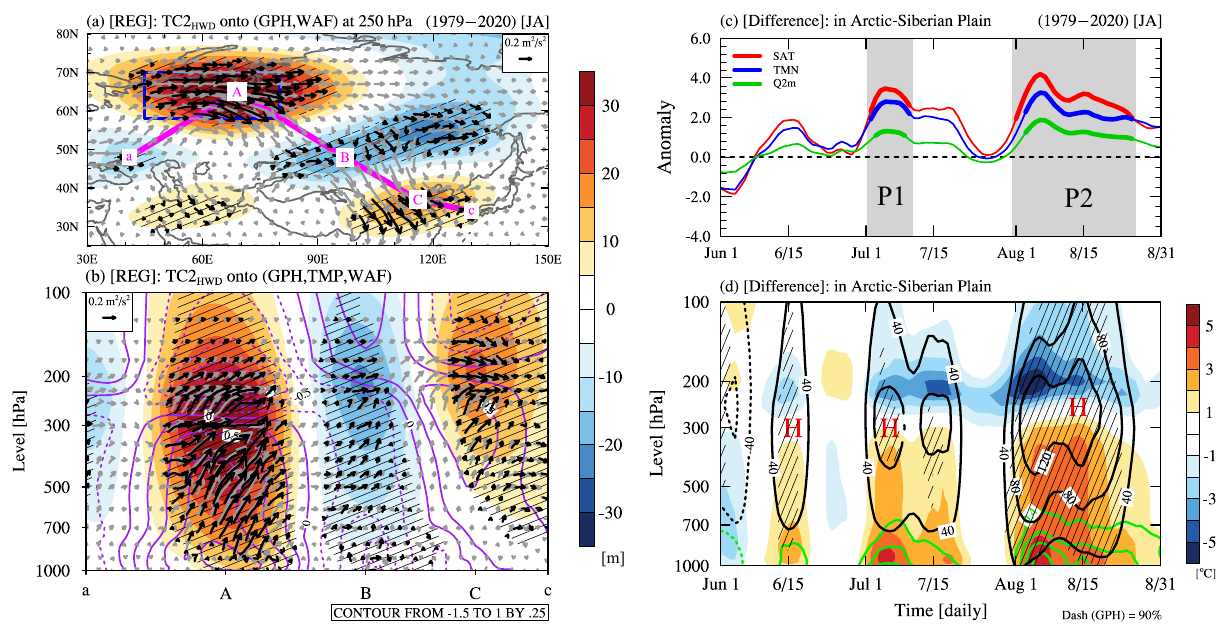
Figure 3. Regression and composite pattern associated with the Arctic-Siberian Plain (ASP). ( a and b ) Horizontal and vertical regression patterns between the 2nd SVD mode time coefficients (TC2) for heatwave days (HWD) (TC2-HWD) and geopotential height (GPH; shading; units: m), wave activity flux (WAF; vector; unit: m 2 /s 2 ), and air temperature (TMP; purple line; unit: °C). The blue rectangle in ( a ) indicates the ASP region (58°N–70°N, 45°E–80°E). The solid pink line indicates a Rossby wave pathway. The black vectors indicate statistically significant values at a 90% confidence level. ( c and d ) Composite difference between heatwaves associated with ASP (HW-ASP) and non-heatwaves associated with ASP (NHW-ASP) for ( c ) 7-day running mean surface air temperature (SAT; red line; unit: °C), minimum temperature (TMN; blue line; unit: °C), and 2 m specific humidity (Q2m; green line; unit: g/kg) and (d) TMP (shading; unit: °C), GPH (black contour; units: m), and specific humidity (green contour; unit: g/kg). The thick solid line in ( c ) and the hatched patterns in ( d ) indicate the values statistically significant at a 90% confidence level. Gray shading indicates period 1 (P1; July 02–July 10) and period 2 (P2; August 01–Augusy